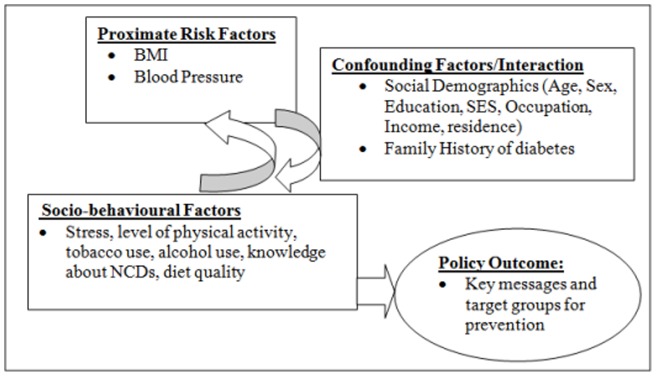
Conceptual framework on socio-behavioural factors likely associated with BMI and blood pressure (Developed by the authors).